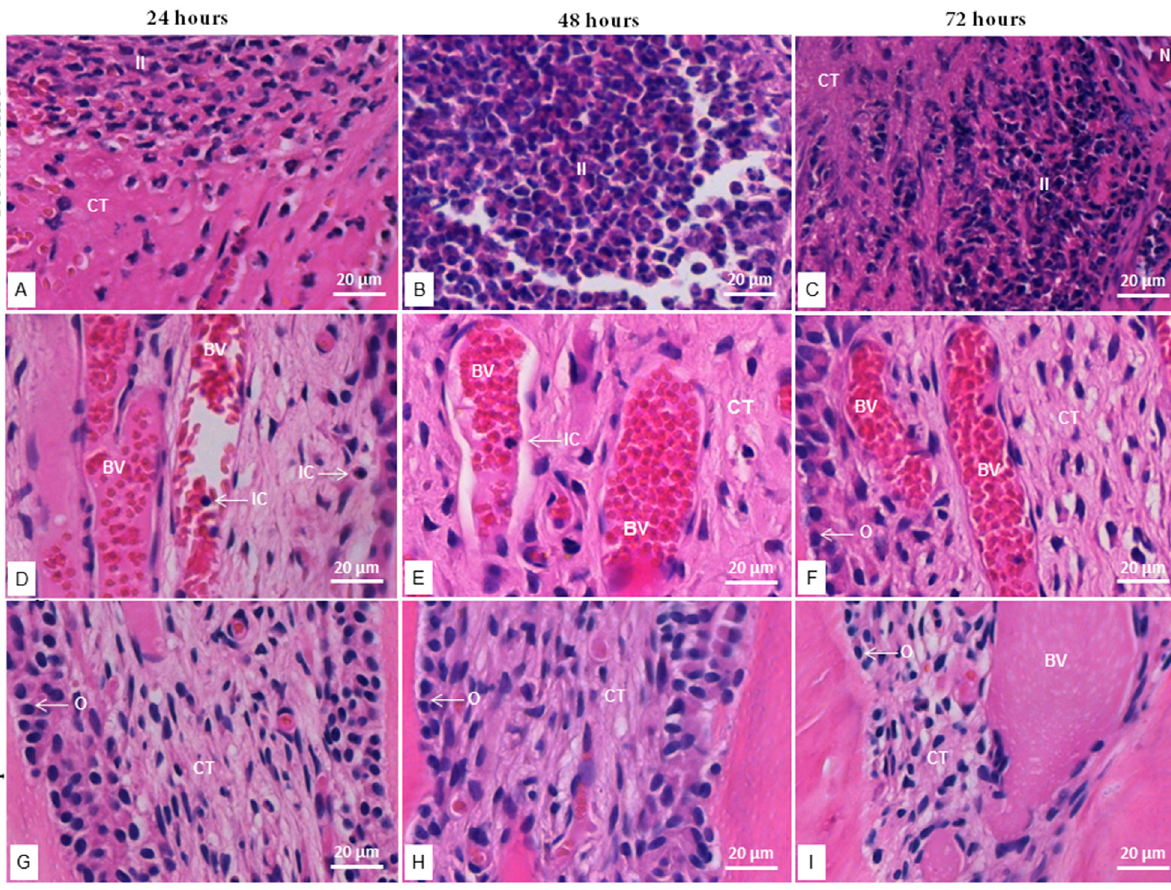
Figure 3- Photomicrographs of hematoxylin and eosin-stained radicular third sections of MTA-treated teeth at 24, 48 and 72 hours. a-c: Cervical radicular third at 24, 48 and 72 hours, respectively; d-f: Medium radicular third at 24, 48 and 72 hours, respectively; g-i: Apical radicular third at 24, 48 and 72 hours, respectively. (II) inflammatory infiltrate; (N) necrosis; (BV) blood vessels; (CT) connective tissue; (O) odontoblast; (IC) inflammatory cell. 40x